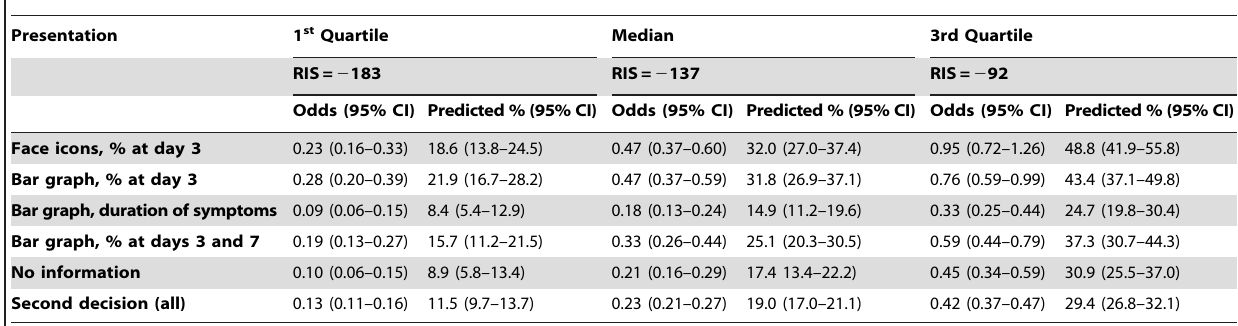
Table 3. Likelihoods for deciding to go to doctor in relation to values (RIS).